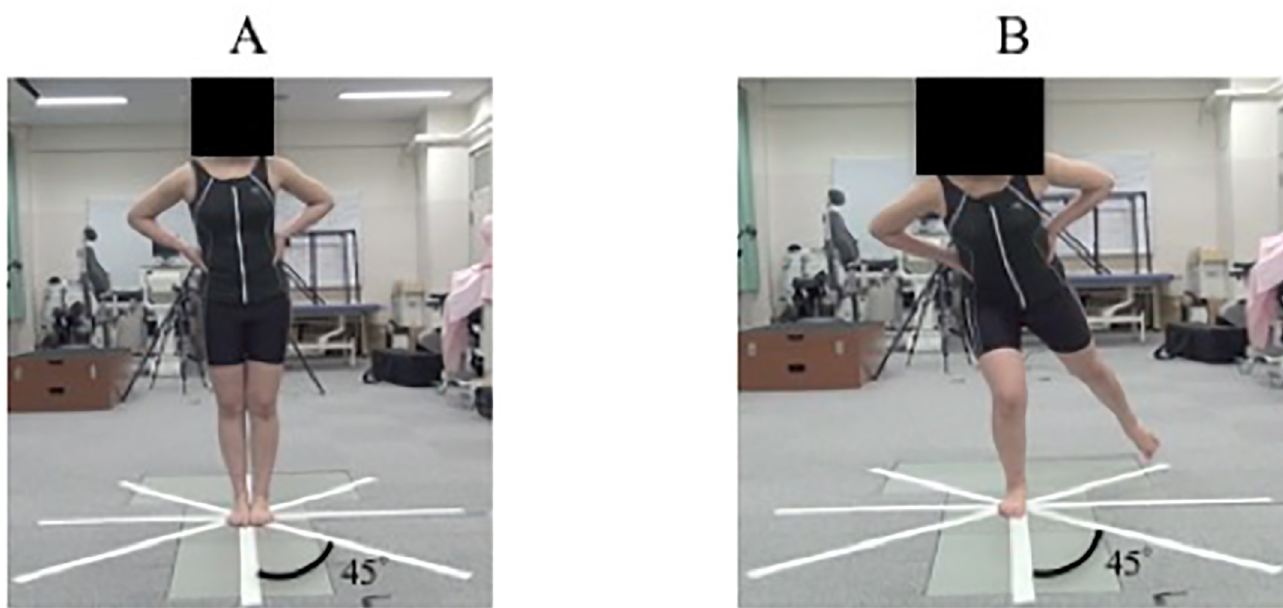
Fig 2. The Star Excursion Balance Test. (A) The Star Excursion Balance Test (SEBT). (B)Start position is standing. The SEBT was performed in single leg standing on the dominant leg at the centre of a grid pattern with lines drawn on the ground at 45 degrees to each other.